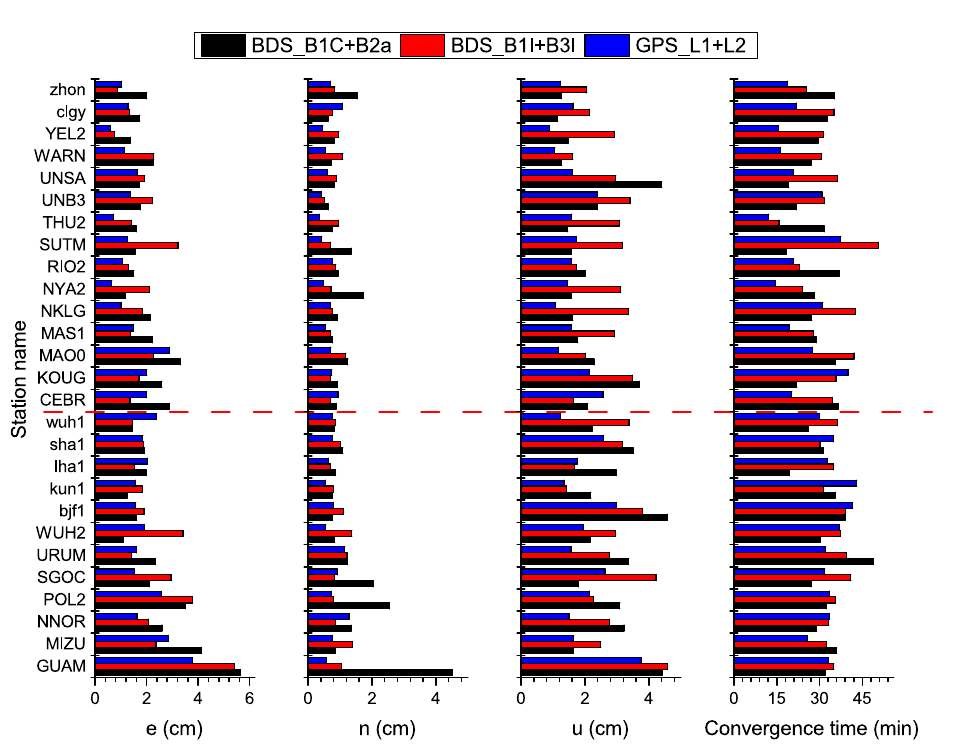
Figure 10. RMS statistics of dual-frequency PPP positioning errors and convergence time for stations in the Asian-Pacific region (below the red dash line) and other regions (above the red dash line). The MGEX station names are in the capital letters and the iGMAS station names are in the lowercase